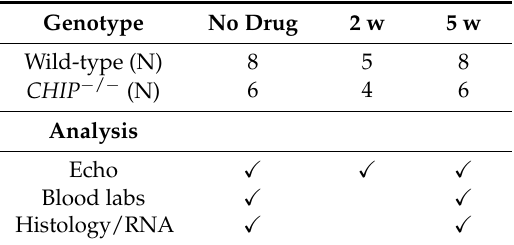
Table 1. Design of the